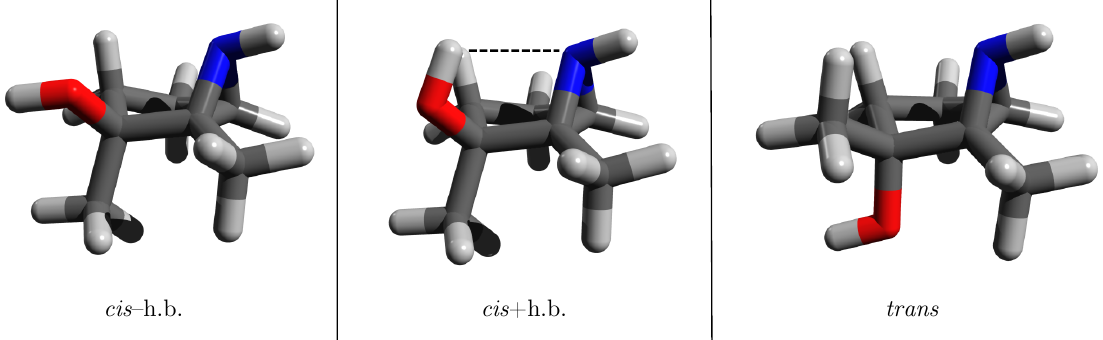
Figure 4. Three structural motifs of the 1,2-dimethyl-2,3-aziridine cyclopentanols: cis isomer without hydrogen bond ( left ), cis isomer with hydrogen bond ( center ), trans isomer ( right